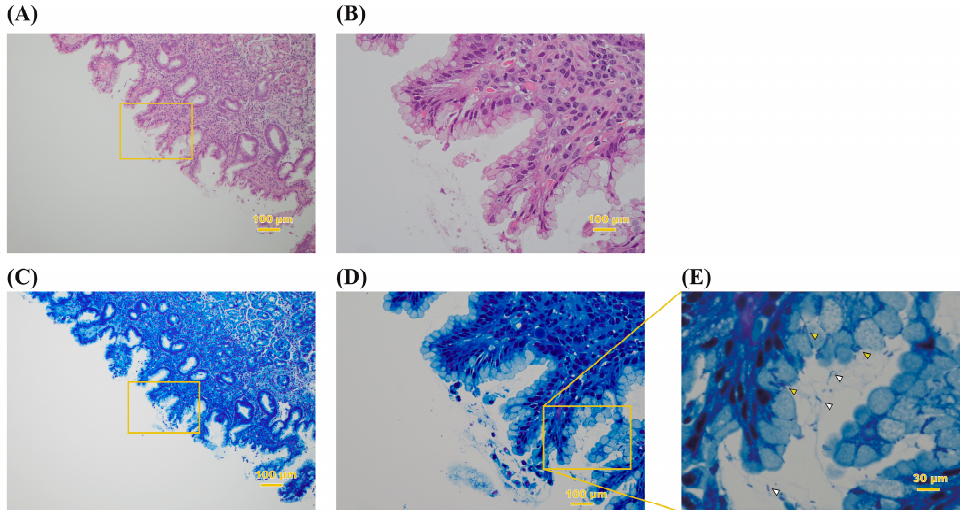
Figure 1. Histopathological observation of biopsy specimen. The gastric mucosa stained with HE ( A , B ) and Giemsa ( C – E ) of patient no. 15. The original magnification is × 10. ( B , D ) Higher magnification of the area indicated by the squares in ( A , C ), respectively. ( E ) High-magnification image of the box in ( D ). Spiral-like and seagull-like bacilli can be confirmed in the mucus (white arrowhead) and the interior of mucous cells (yellow arrowhead) of the stomach.